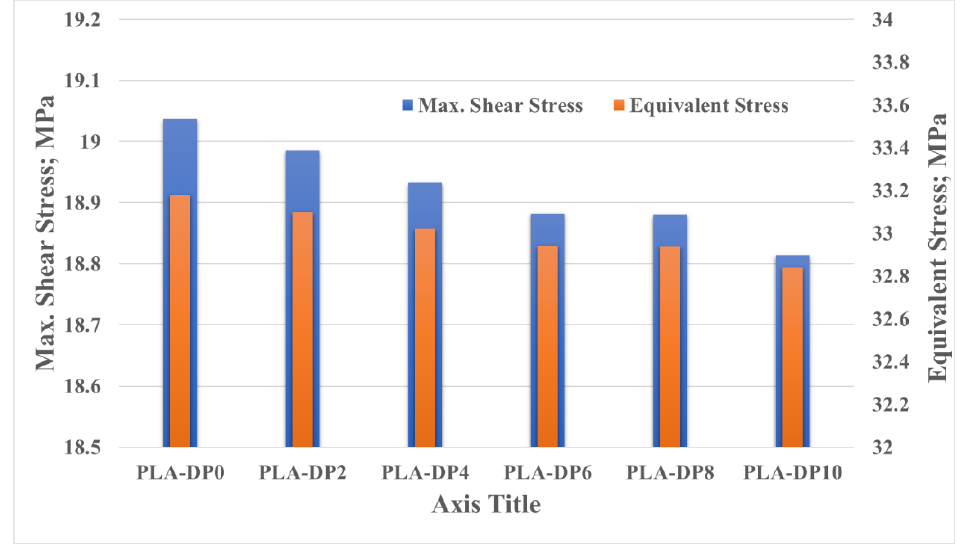
Figure 16. Contact stresses on the surface of the articulated cup of the hip joint.